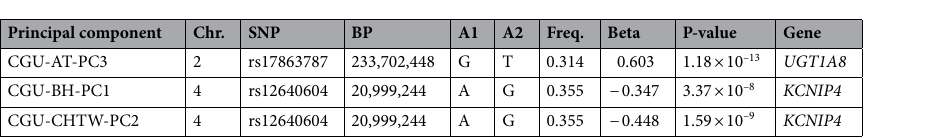
Table 2. Combination PCs with genome-wide significant association